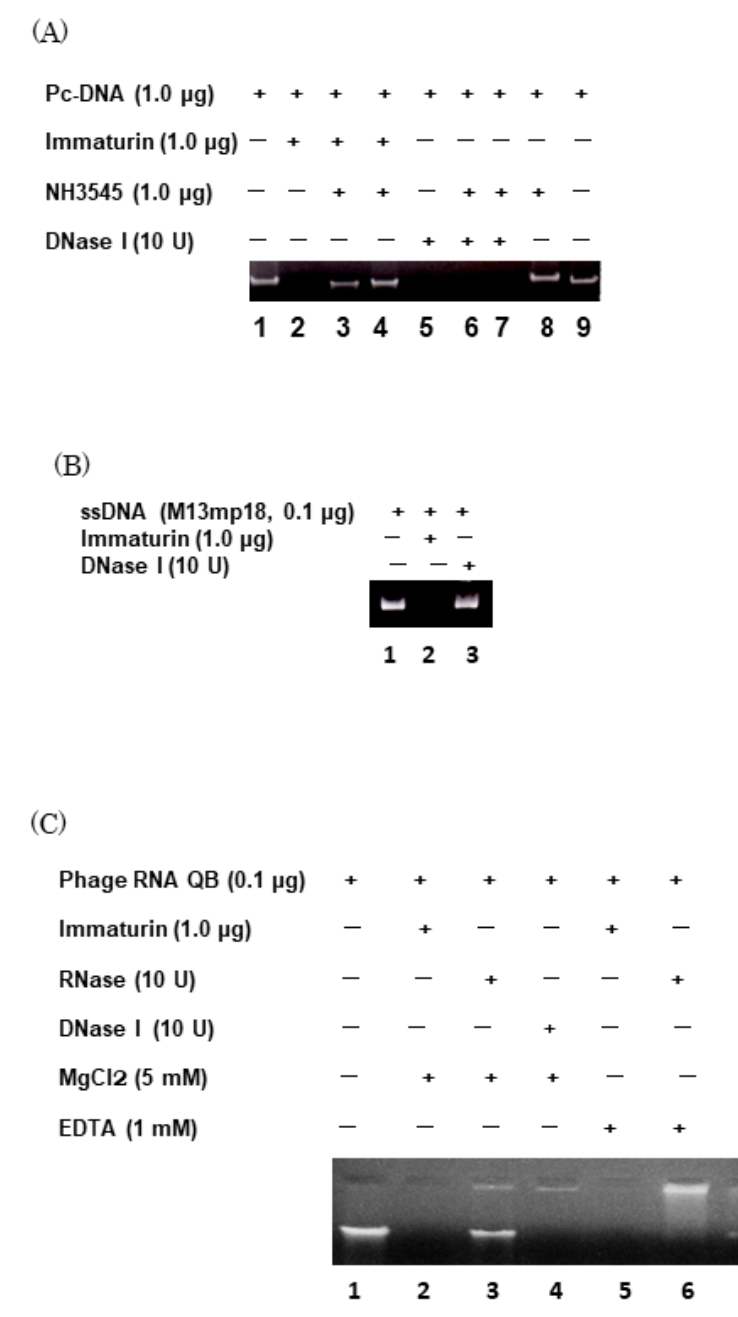
Figure 7. Characterization of immaturin-nuclease activity. ( A ) The purified immaturin fraction was pre-incubated with NH3545 (0.15 (lanes 3 and 6) or 0.31 mg protein/mL (lanes 4, 7, and 8)) for 24 h at 4 °C. Immaturin-antibody NH3545 inhibited immaturin nuclease activity, but E. coli DNase I was not inhibited by NH3545. ( B ) Immaturin nuclease digested single-stranded DNA, but E. coli DNase I did not. ( C ) Immaturin nuclease digested double-stranded phage genomic RNA (QB), but RNase A ( E. coli ) did not.